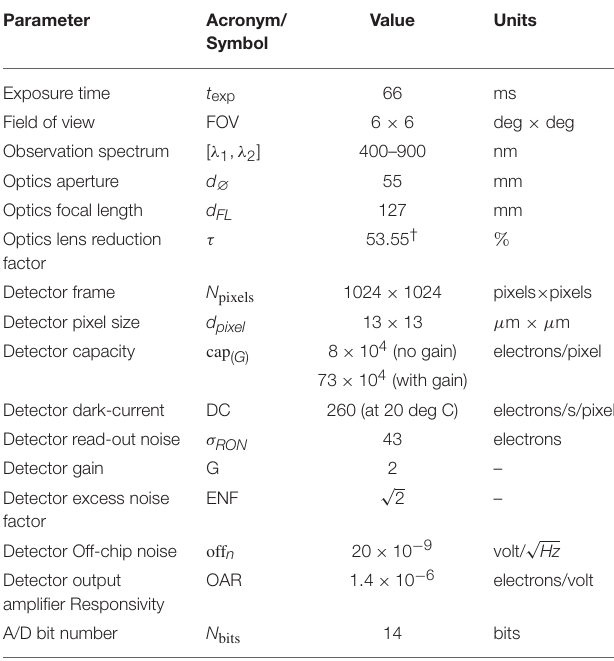
TABLE 4 | LUMIO-Cam parameters, including those of the chosen detector (Teledyne e2V CCD201-20*).